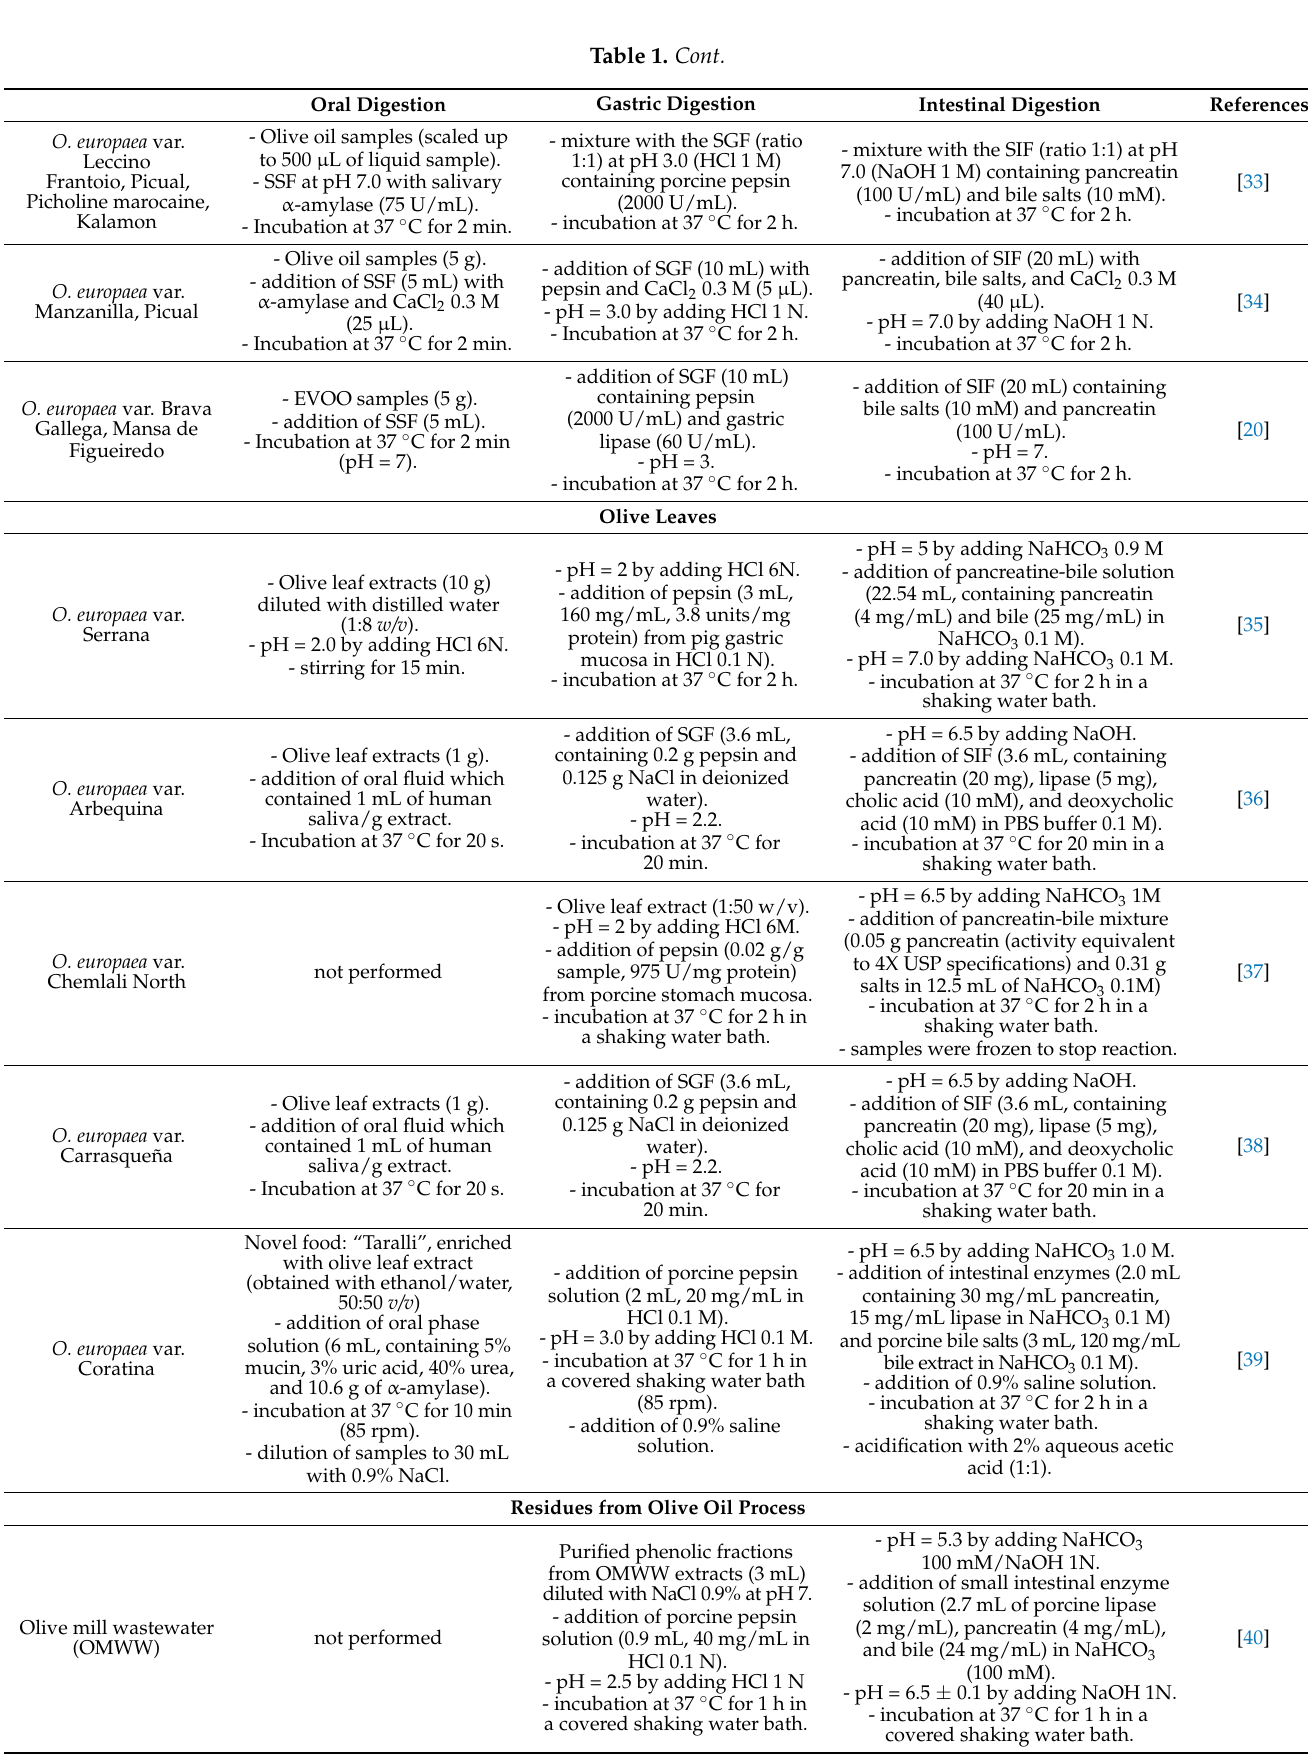
- EVOO samples (5 g). - addition of SSF (5